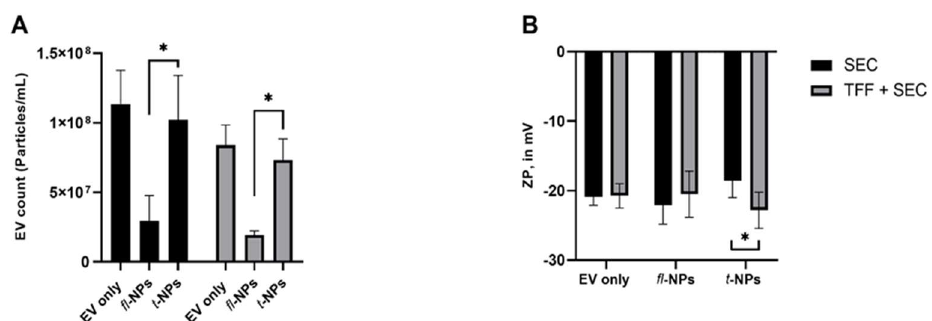
Figure 9. Concentration and zeta potential of fluorescent and total NPs for JAr EVs purified in SEC alone and combination of TFF. Particle concentration ( A ) and zeta potential ( B ) for respective EV only controls, fl- , and t-NPs of JAr EVs measured in fluorescent and scatter modes of NTA. All EV types were labeled with 100 ng/mL of CMG and fl- NPs were measured at a minimum brightness threshold value of 25. The concentration of fl- NPs of JAr EVs purified in SEC and in combination with TFF was significantly different ( p ≤ 0.05) than the corresponding t-NPs of JAr EVs purified with SEC alone and in combination with TFF. Thus, were marked with an asterisk (*) symbol. EVs were diluted in 1 × PBS, and the ZP measurement was done at a neutral pH of 7.2 (mean ± SD, n = 9).